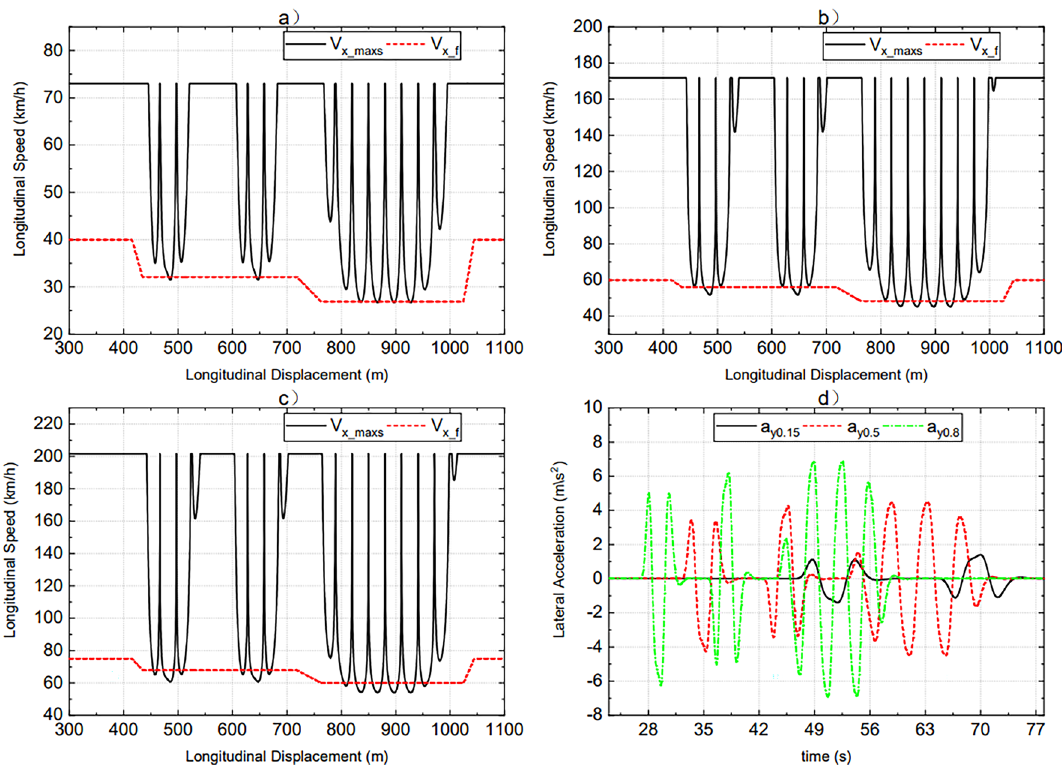
Figure 5. ( a – c ) are the speed preview results with road adhesion coefficients of 0.15, 0.5, and 0.8 under the given path, ( d ) is the lateral acceleration of DDAVs under these three road adhesion coefficients when SCS is used.